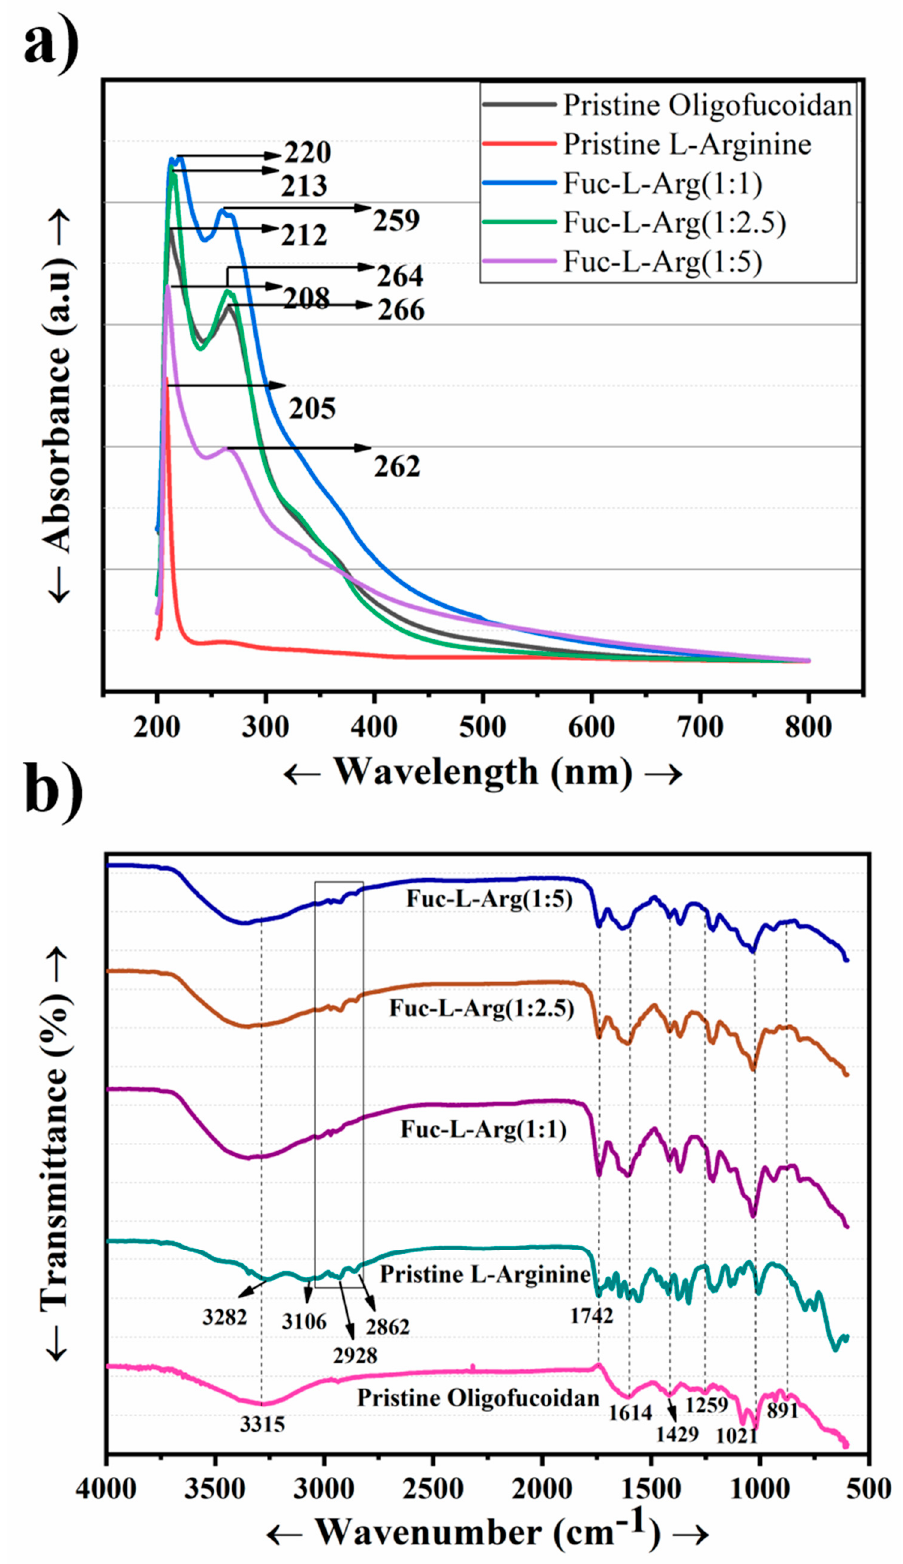
Figure 1. ( a ) UV absorbance of fucoidan, L-arginine, and their complexes; ( b ) FT-IR characterization of fucoidan, L-arginine, and their complexes